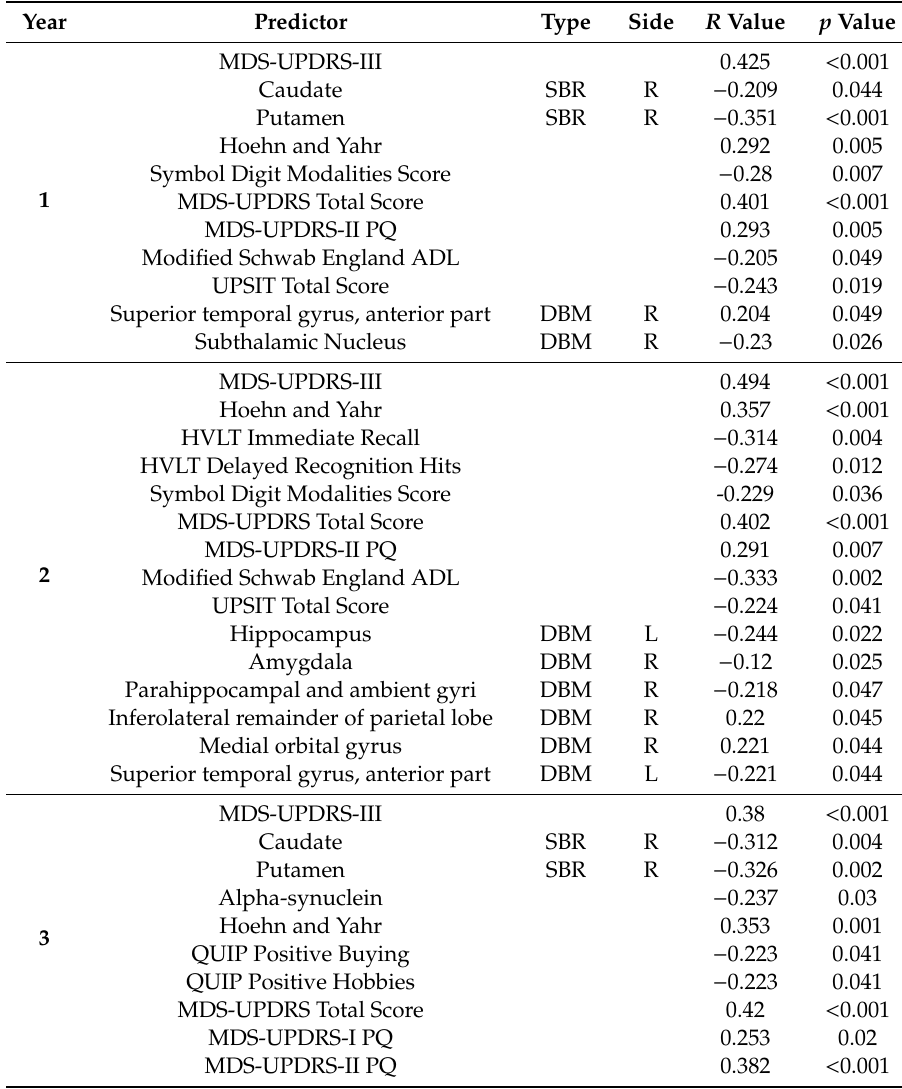
Table 1. MDS-UPDRS-III Spearman’s rank correlation coe ffi cients of only baseline predictors at four time points past